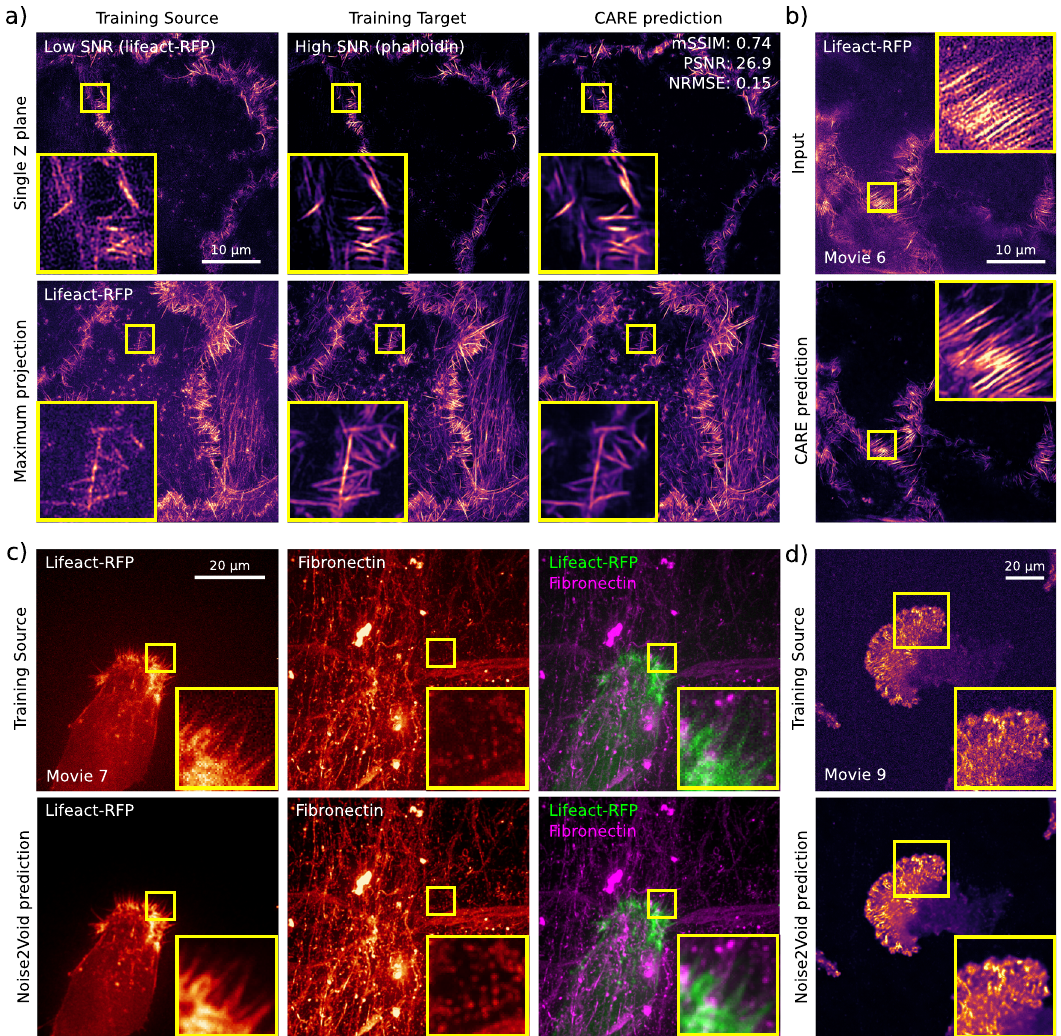
Fig. 4 Image denoising and restoration networks (CARE and Noise2Void). Example of data generated using ZeroCostDL4Mic CARE and Noise2Void notebooks. a , b A 3D CARE network was trained using SIM images of the actin cytoskeleton of DCIS.COM cells using fi xed samples ( a ) to denoise live-cell imaging data ( b ). Quality control metrics are as follows: mSSIM: 0.74, PSNR: 26.9 and NRMSE: 0.15. c Fixed samples were imaged using SIM to obtain low signal-to-noise images (lifeact-RFP, Training Source) and matching high signal-to-noise (Phalloidin staining, Training Target) images, and this paired dataset was used to train CARE. Input, ground truth and a CARE prediction are displayed (both single Z plane and maximal projections). The QC metrics values computed directly in the CARE notebook are indicated. b The network trained in ( a ) was then used to restore live-cell imaging data